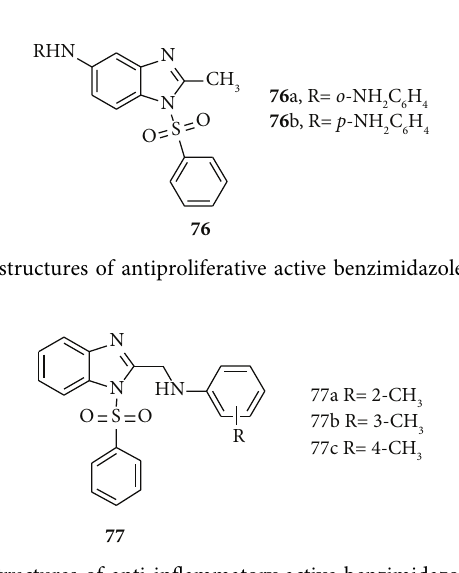
Figure 5: Chemical structures of antiviral active benzimidazole-sulfonyl derivatives.